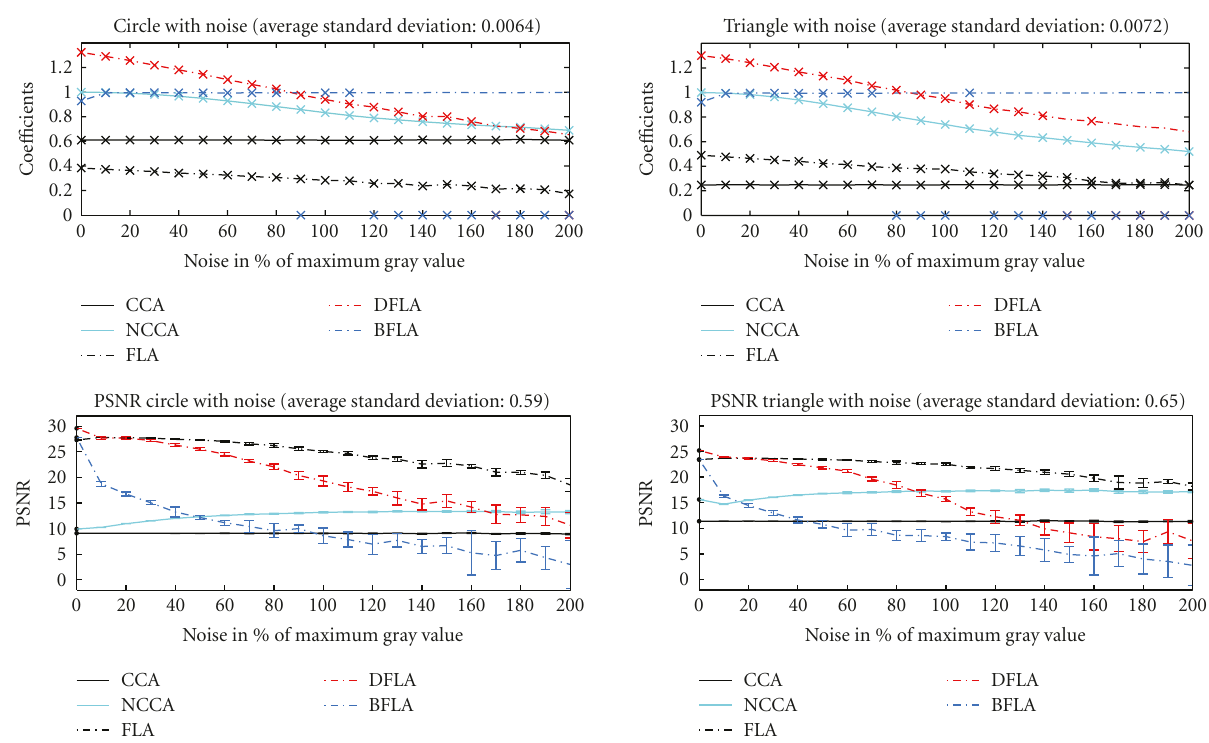
Figure 4: Influence of changes in noise on the coe ffi cients and the PSNR of the cross-correlation algorithms. Top: coe ffi cients of the correla- tion algorithms, (marker—the correct position always detected); bottom: PSNR and standard deviation of the cross-correlation algorithms; left: results of the circles; right: results of the